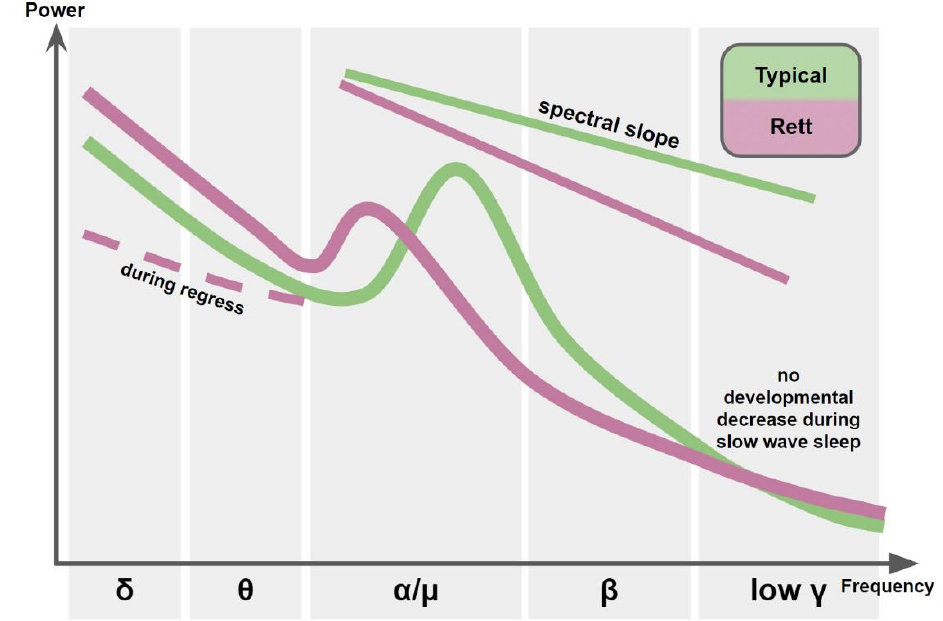
Figure 2. Spectral features of EEG in RTT.